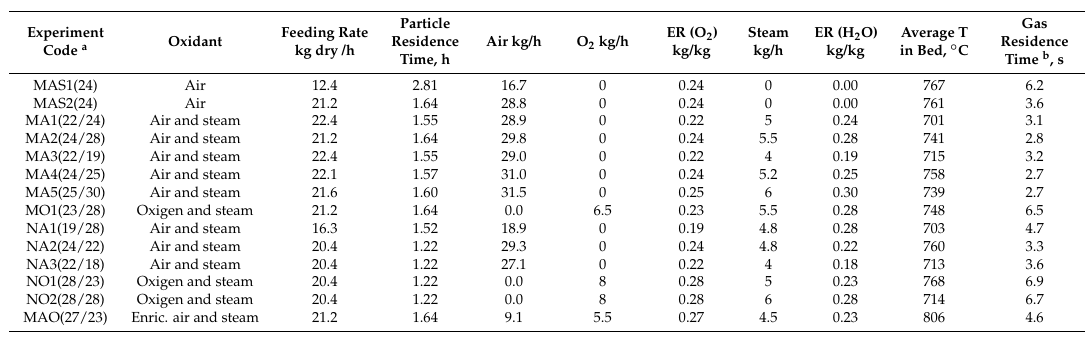
Table 3. Test coding of shells gasification: experimental parameters; calculated Equivalence Ratios, average temperature of the fixed bed, calculate residence time of the gas in the